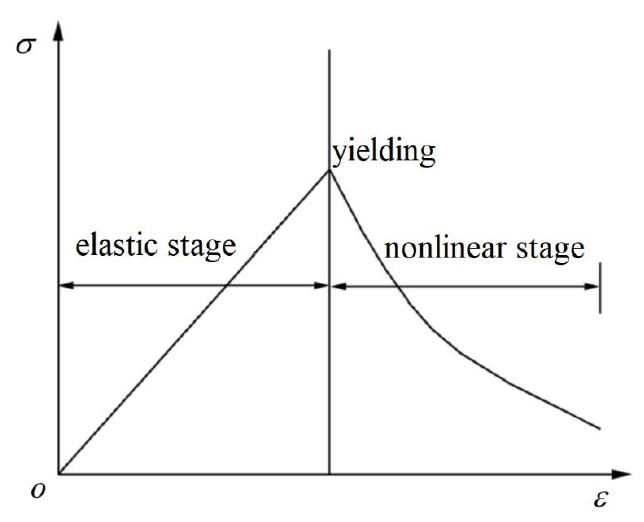
Figure 16. Element’s stress–strain relation.